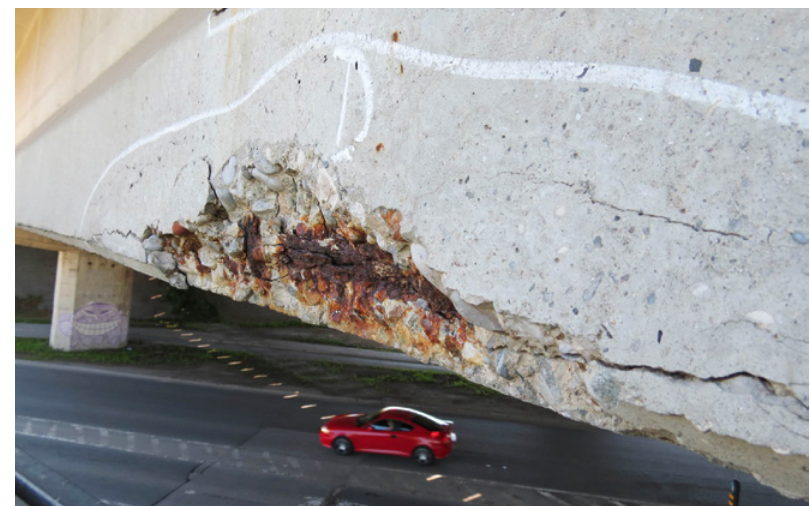
Figure 1. Delaminated concrete cover due to the corrosion of the reinforcement on a roadway